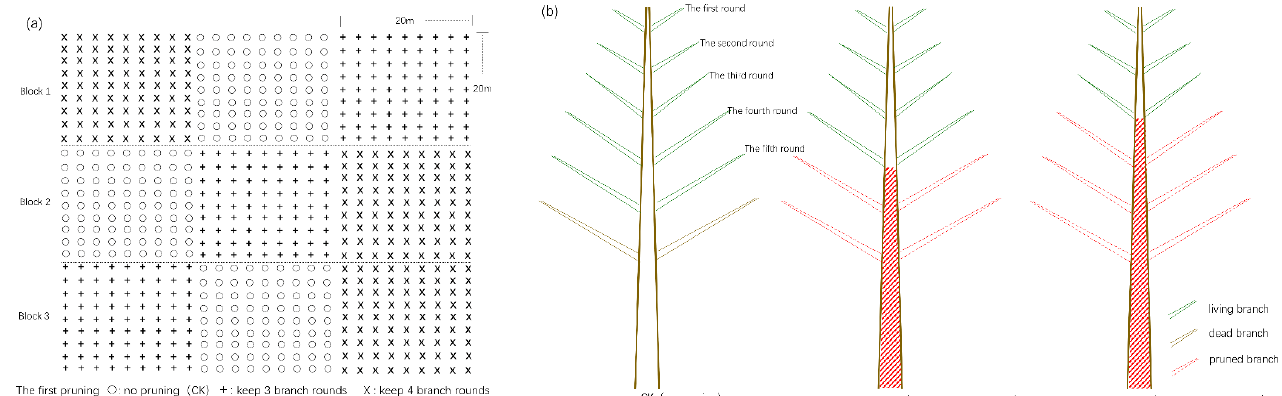
Figure 1. Set-up of the trail in Duyun, Guizhou, China, showing the arrangement of sample plots with three blocks and treatments ( a ) and the pruning diagram ( b ) of the fi rst pruning. Di ff erent symbols represent di ff erent treatments in the arrangement diagram. The red marks represent the pruning parts in the pruning diagram. The same is below.